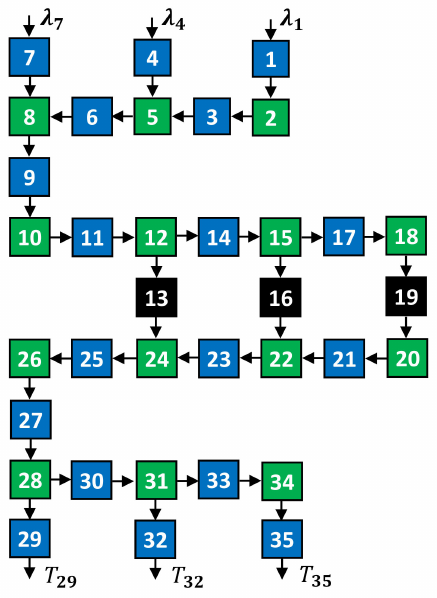
Figure 15. Large-scale